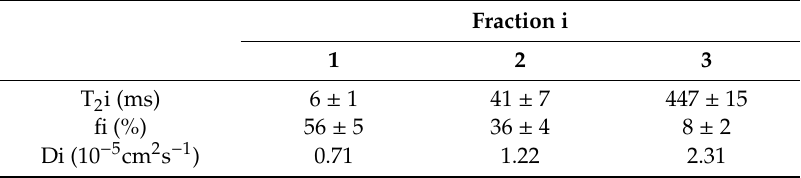
Table 1. Transverse relaxation time (T 2 i), population (fi), and di ff usion coe ffi cient (Di) values (mean ± standard deviation) related to each water fraction i obtained for hydrated